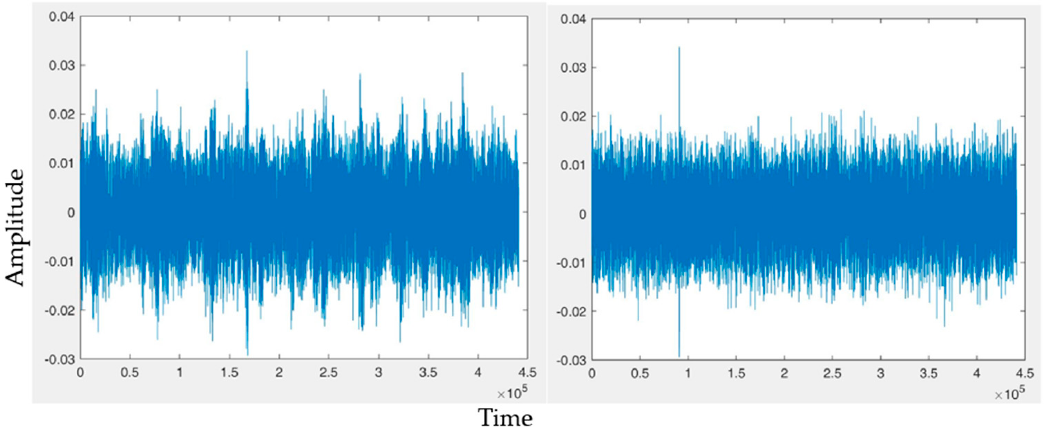
Figure 6. Active vs. fatigue voice pa tt ern.